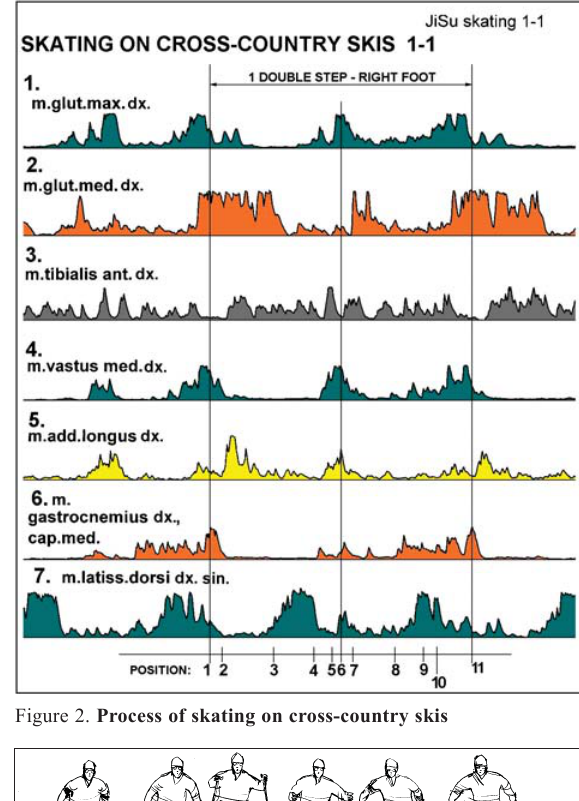
Figure 2. Process of skating on cross-country skis